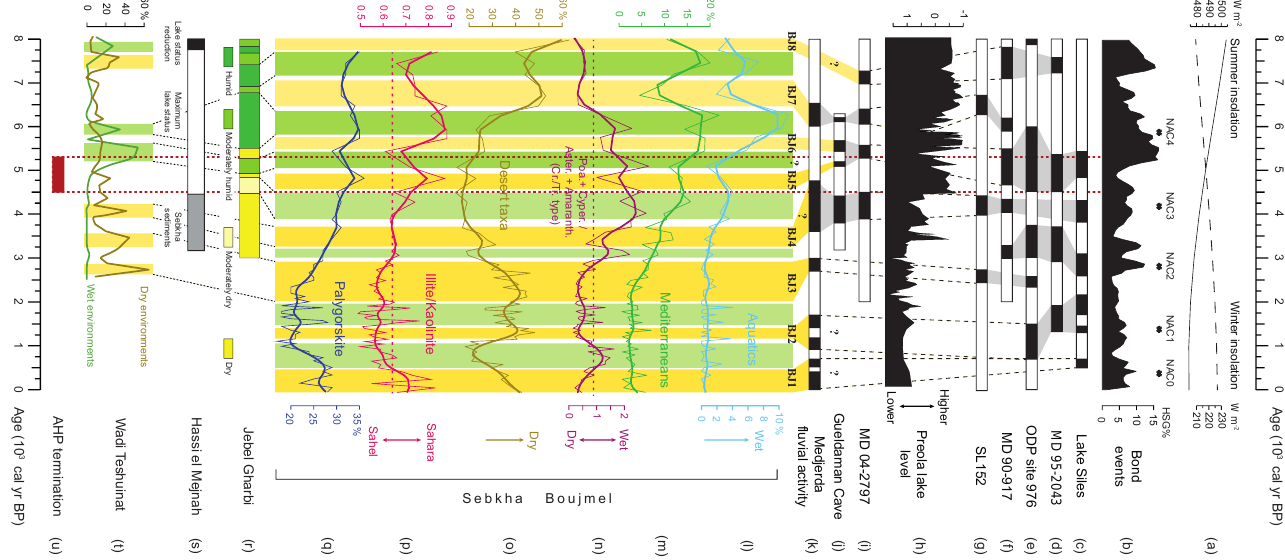
Figure 4. Comparison of pollen and clay mineralogy data from BJM2 core with paleoclimate records from the Mediterranean and the Sahara. (a) Summer (June mid-month) and winter (December mid-month) insolation (Wm − 2 ) curve at 30 ◦ N (Berger and Loutre, 1991). (b) Drift ice record from the North Atlantic: stacked percentage of HSG (hematite stained grains) of four records with stars indicate the North Atlantic cooling events (Bond et al., 2001; Bond et al., 1997). (c) Desiccation events at Lake Siles (southern Spain, 38 ◦ 24 (cid:48) N, 2 ◦ 30 (cid:48) W) based on Pseudoschizaea microfossil abundance (Carrión, 2002a). (d) Episodes of Mediterranean forest decline based on pollen data from MD 95- 2043 core in the Alboran Sea (36 ◦ 9 (cid:48) N, 2 ◦ 37 (cid:48) W) (Fletcher et al., 2012). (e) Temperate forest decline events ODP site 976 core in the Alboran Sea (36 ◦ 12 (cid:48) N, 4 ◦ 18 (cid:48) W) (Combourieu Nebout et al., 2009). (f) Cold and dry events on core MD 90-917 (41 ◦ N, 17 ◦ 37 (cid:48) E) pollen record from the Adriatic Sea (Combourieu-Nebout et al., 2013). (g) Arid events from SL152 core (Aegean sea, 40 ◦ 19 (cid:48) N, 24 ◦ 65 (cid:48) E) (Kotthoff et al., 2008a, b; Schmiedl et al., 2010). (h) Lake-level fluctuations (CA scores) at Lago Preola in Sicily (37 ◦ 37 (cid:48) N, 12 ◦ 38 (cid:48) E) (Magny et al., 2011). (i) Identified arid spells on pollen data from MD 04-2797 core in the Siculo-Tunisian Strait (36 ◦ 57 (cid:48) N, 11 ◦ 40 (cid:48) E) (Desprat et al., 2013). (j) Drought episodes based on stable isotopes record from stalagmite GLD1-stm4, Gueldaman Cave, N Algeria, (36 ◦ 26 (cid:48) N, 4 ◦ 34 (cid:48) E) (Ruan et al., 2016). (k) Phases of increased fluvial activity with low soil formation and arid climate in the Medjerda River valley, northern Tunisia (Faust et al., 2004; Zielhofer et al., 2004). Pollen and clay mineralogy data from Sebkha Boujmel (BJM2 core, 33 ◦ 16 (cid:48) N ◦ , 11 ◦ 05 (cid:48) E) with bold lines showing the cubic smoothing splines and dashed lines averages for the I / K and W / D ratios. (l) Percentages of fresh water (Cyperaceae, Glyceria , Juncus , Lemna , Potamogeton , Rumex aquaticus -t., Typha / Sparganium -t.) and (m) Mediterranean tree and shrub ( Buxus , Ceratonia, Cistus , Juniperus , Lamiaceae, Myrtus , Nerium , Olea , Papaveraceae, Pinus , Pistacia , Quercus ilex- t., Quercus deciduous-t., Rhus tripartita -t.) pollen taxa. (n) Wet / dry (W / D) pollen ratio (Poaceae + Cyperaceae/Asteraceae Cichorioideae + Asteraceae Asteroideae + Amaranthaceae Cornulaca / Traganum -t.). (o) Percentages of desert pollen taxa (Apiaceae, Asphodelus , Asteraceae Asteroideae, Asteraceae Cichorioideae, Calligonum , Capparis , Cistanche, Cleome , Cornulaca / Traganum -t., Crassulaceae, Cucurbitaceae, Echium , Ephedra distachia -t., Ephedra fragilis -t., Fagonia, Helianthemum , Malvaceae, Moltkiopsis ciliata , Neurada , Nitraria, Onosma , Reaumuria , Tamarix and Zygophyllum ). (p) Illite / kaolinite ratio and (q) palygorskite percentages. (r) Holocene climatic events in the Libyan Jeffara (Jebel Gharbi, north-western Libya, 32 ◦ N) based on sedimentological and palynological data (Giraudi et al., 2013). (s) Paleohydrological changes at Hassi el Mejnah in Algeria (31 ◦ 14 (cid:48) N, 2 ◦ 30 (cid:48) E) (Gasse, 2002; Hoelzmann et al., 2004). (t) Pollen data from rock shelters in the Wadi Teshuinat area (Tadrart Acacus Massif, central Sahara, south-west Libya (24 ◦ 30 (cid:48) –26 ◦ N, 10–12 ◦ E; Cremaschi et al., 2014; Mercuri, 2008). (u) Estimated duration of the African Humid Period termination (4.9ka ± 400, 2 σ ) as indicated by aeolian dust flux data on marine sediment cores from the north-west African margin (McGee et al.,